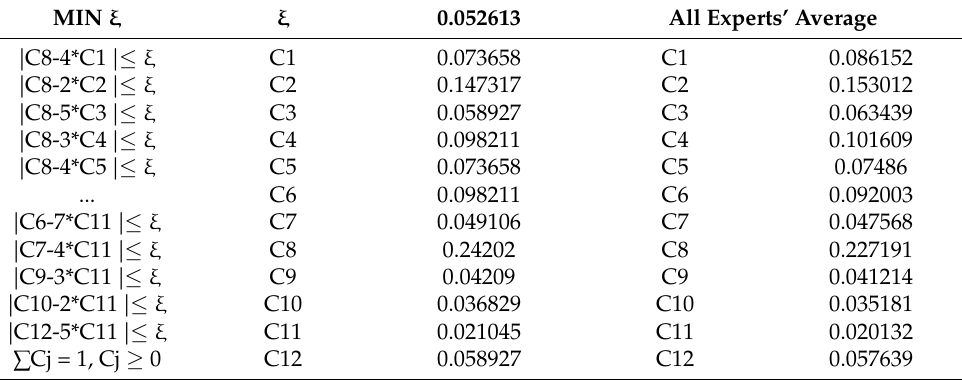
Table 8. Modelling and model solution.